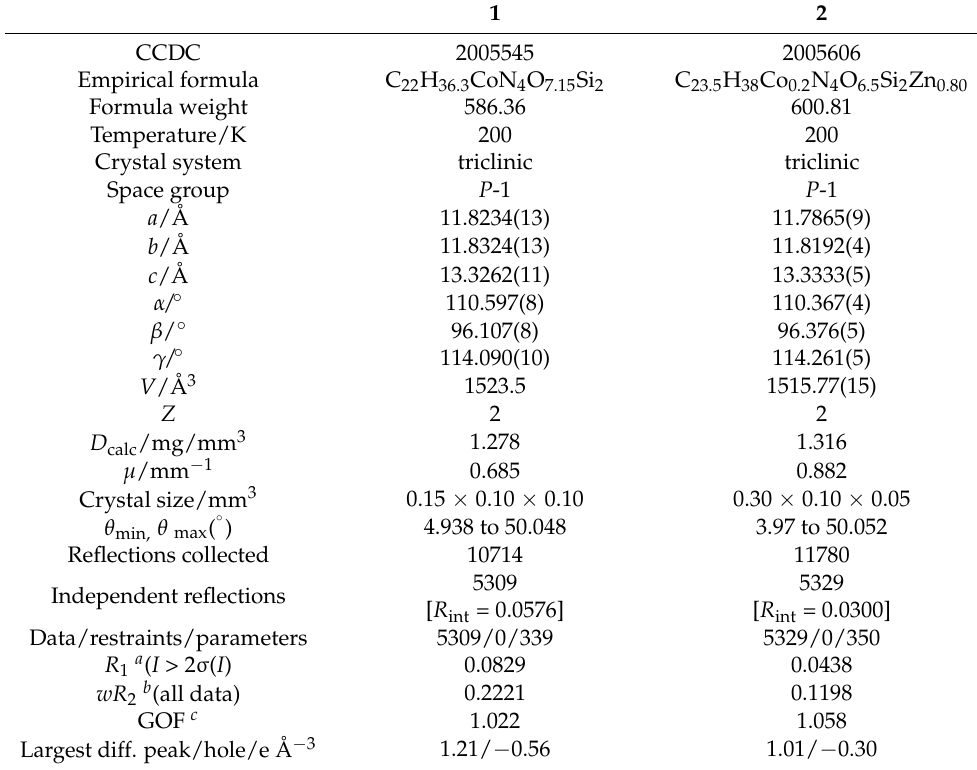
Table 1. Crystallographic